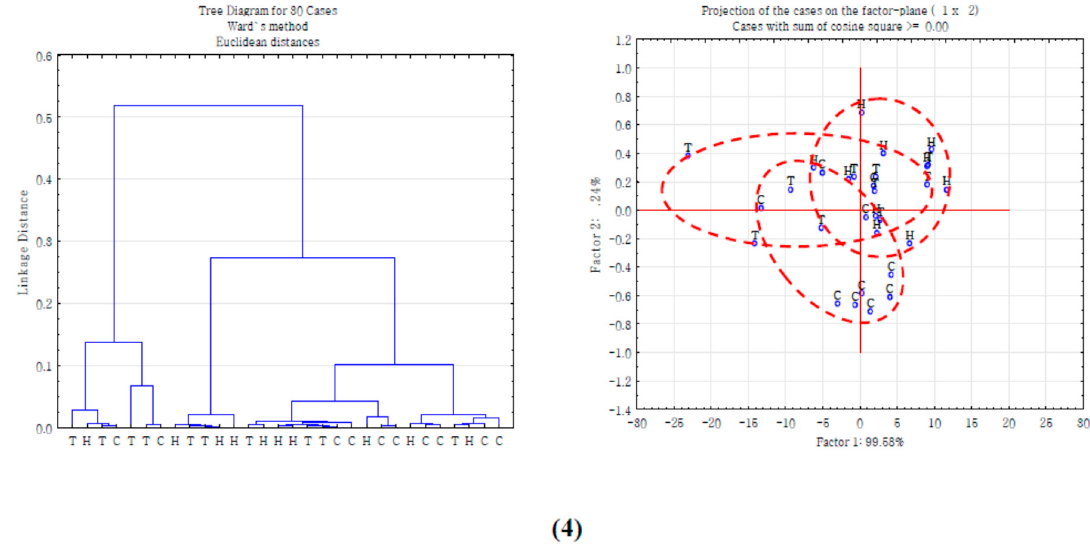
Figure 1. Hierarchical cluster analysis (CLA) and principal component analysis (PCA) of HB12 RNAi alfalfa (H), TT8 RNAi alfalfa (T) and nontransgenic alfalfa (C) for spectral region: (1) structural carbohydrate fingerprint region: ca . 1485–1188 cm − 1 ; (2) cellulosic compound fingerprint region: ca . 1294–1188 cm − 1 ; (3) total carbohydrate fingerprint region: ca. 1190–930 cm − 1 ; (4) non-structural carbohydrate fingerprint region: ca . 931–875 cm − 1 . Cluster methods (Ward’s algorithm) and distance measure (Eculidean distances) were used in CLA analysis. Scatter plots of two principal components (PC1 vs. PC2) in PCA analysis.